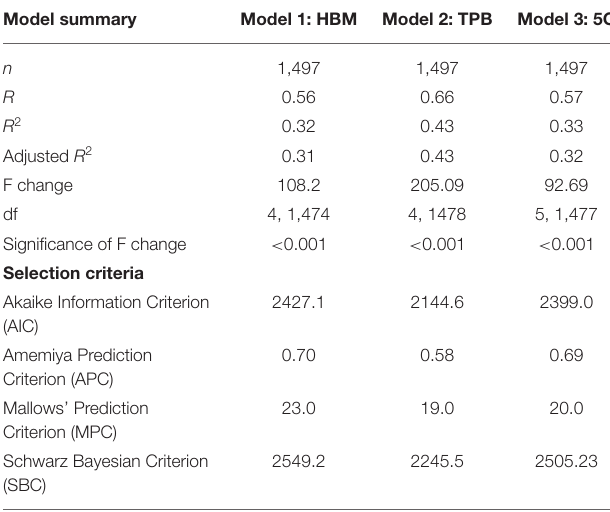
TABLE 4 | Model summary and selection criteria. Model